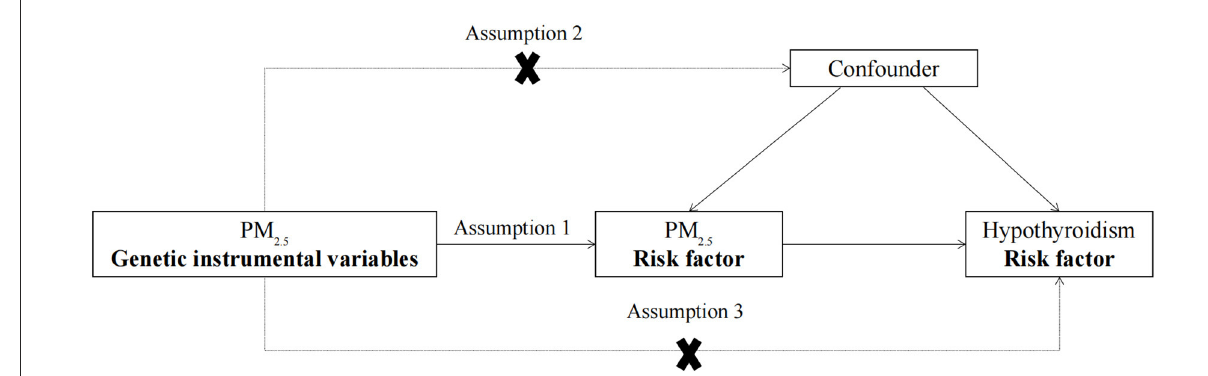
FIGURE1 The design flow chart for the MR study. MR assumptions: assumption 1, 2, and 3. The solid line represents direct putative causal effects that PM 2.5 genetic instrumental variants are reliably associated with I PM 2.5 levels and influence the risk of hypothyroidism through the PM 2.5 in assumption 1. The dotted line represents that PM 2.5 genetic instrumental variants are not associated with any measured and unmeasured confounders and do not influence the risk of hypothyroidism through other pathways in assumptions 2 and 3, respectively. MR, Mendelian randomization; PM 2.5 , particulate matter 2.5.